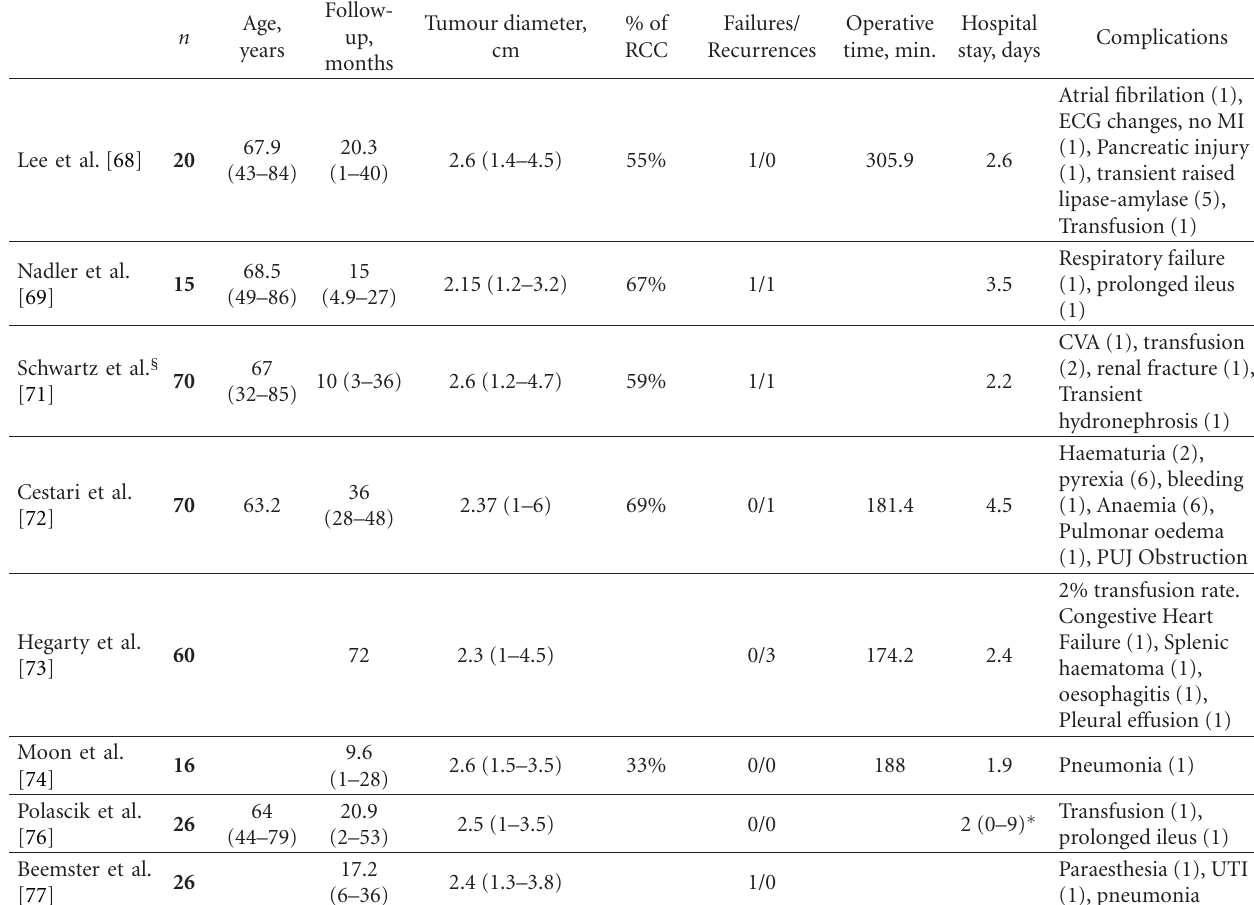
Table 1: Summary of largest reported series on